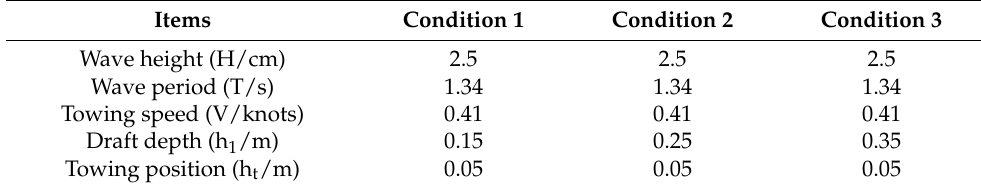
Table 6. Towing conditions for different draft depths.